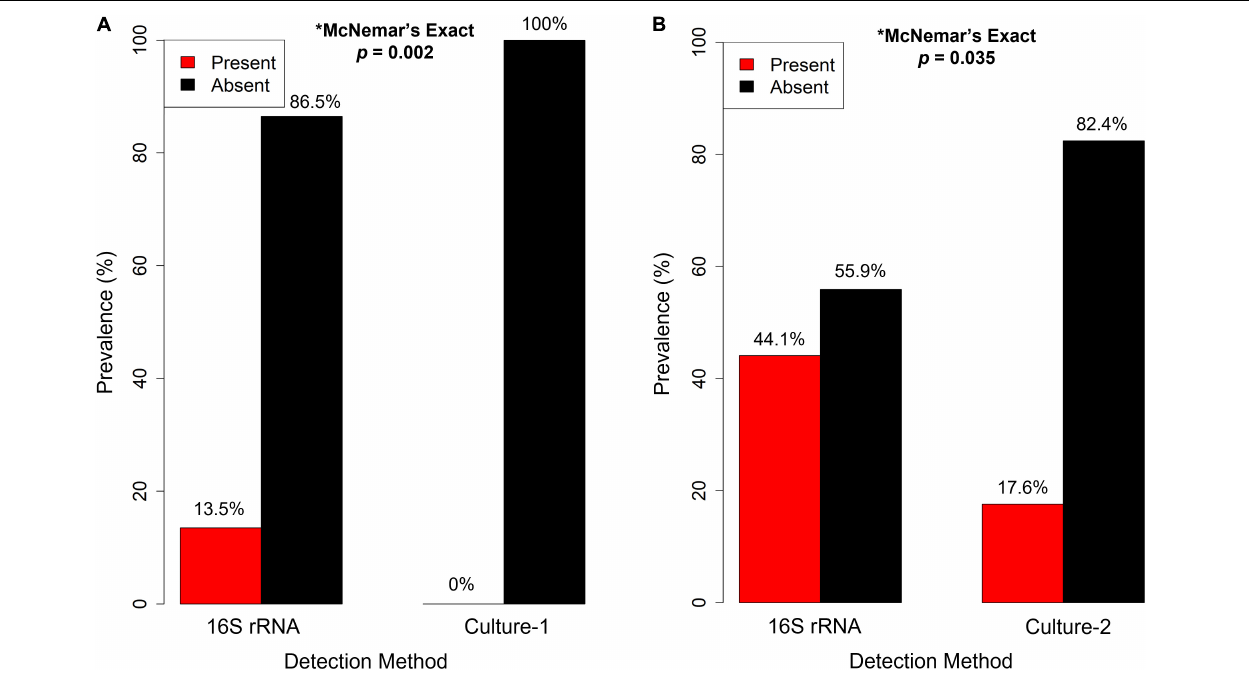
FIGURE 2 | Salmonella spp. prevalence in barn swallows ( Hirundo rustica ) from Israel, estimated using unrarefied 16S rRNA gene sequencing (16S rRNA) and two culture methods: (A) culture workflow 1 (Culture-1; n = 74) and (B) culture workflow 2 (Culture-2; n = 34). The proportion of samples positive for the presence of Salmonella (red bars) detected by 16S rRNA gene sequencing was significantly higher than those obtained by culturing. This analysis was conducted on paired samples from the same individuals that had both culture and 16S rRNA gene data